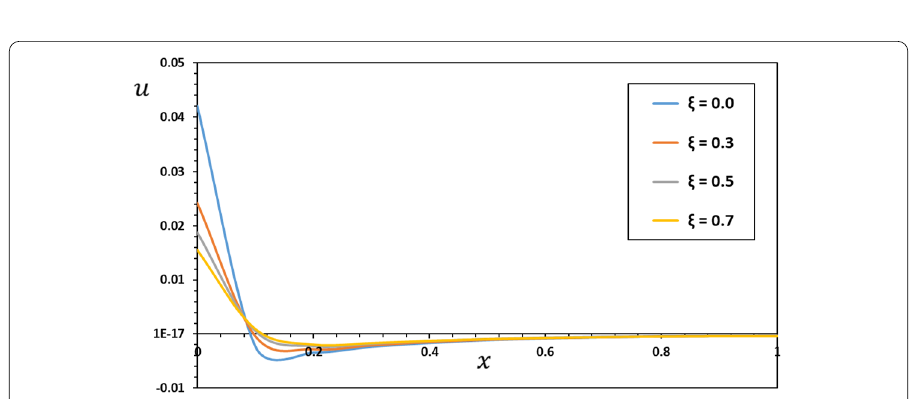
Figure 8 The effect of nonlocality ( ξ ) on the variation of the displacement u